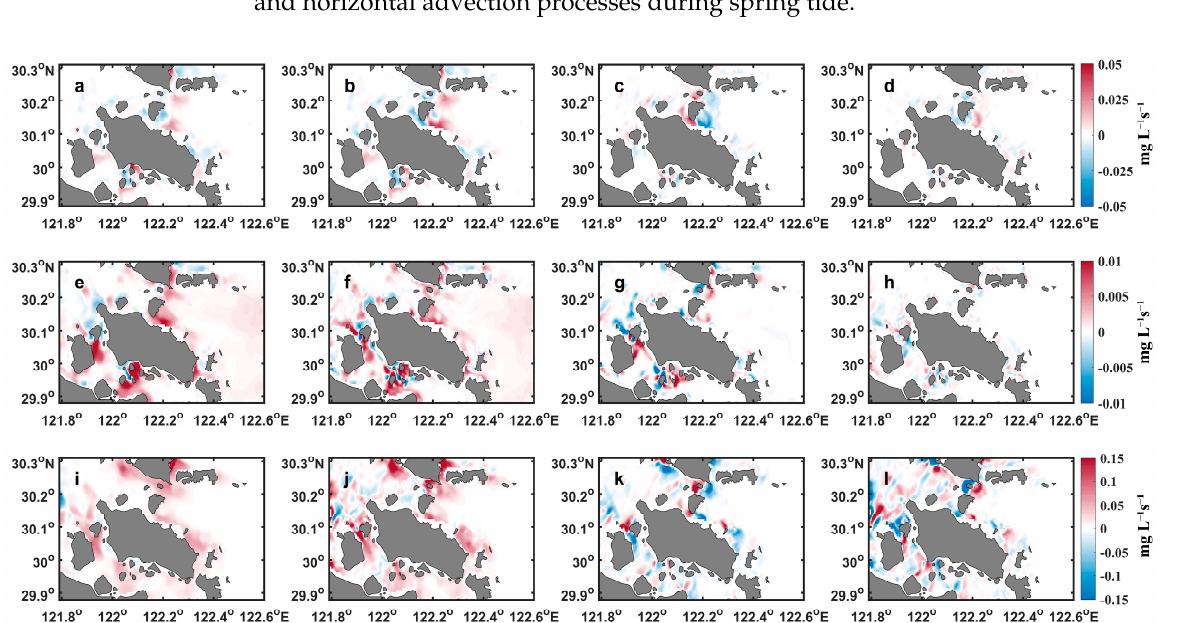
Figure 14. The spatial distributions of the local change (CHA, a ), all terms related to the vertical direction (VER, b ), the horizontal advection (ADV, c ), and the horizontal diffusion (DIF, d ) from 08:28 am to 09:28 am on 13 August 2020. ( e – h ) and ( i – l ) are the same as ( a – d ) but for the spatial distributions of the four terms from 11:28 am to 12:28 pm on 16 August 2020 and 1:28 pm to 2:28 pm on 20 August 2020,